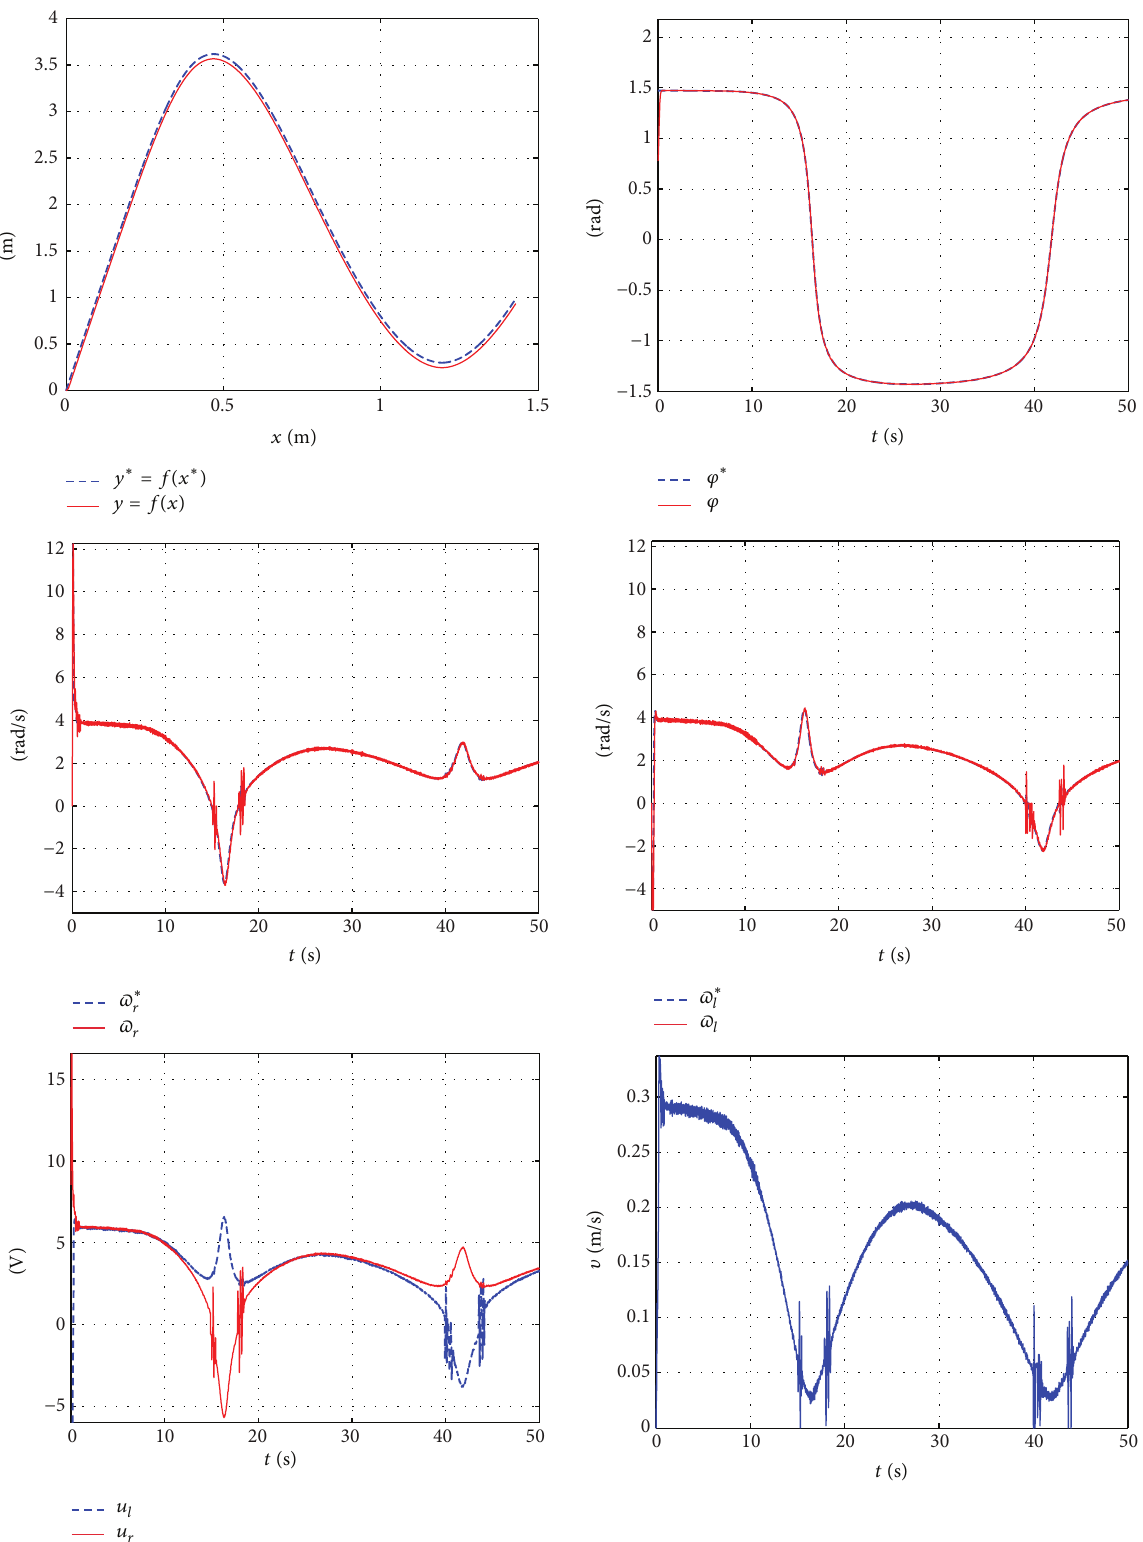
Figure 19: Experimental results for curve obtained by